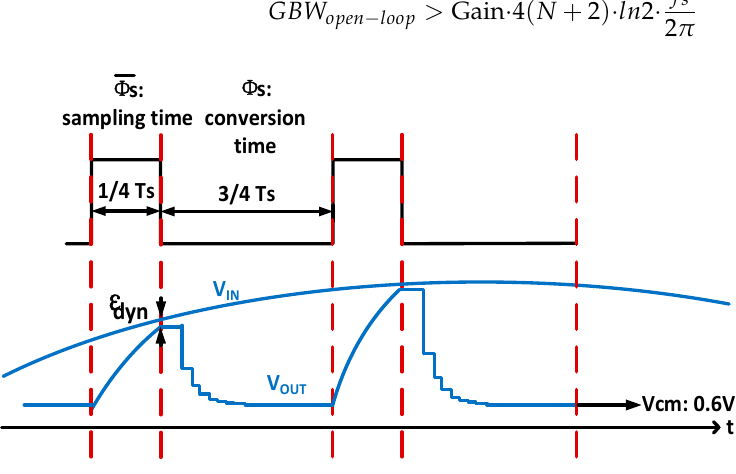
Figure 6. Signal establishment during the sampling phase.